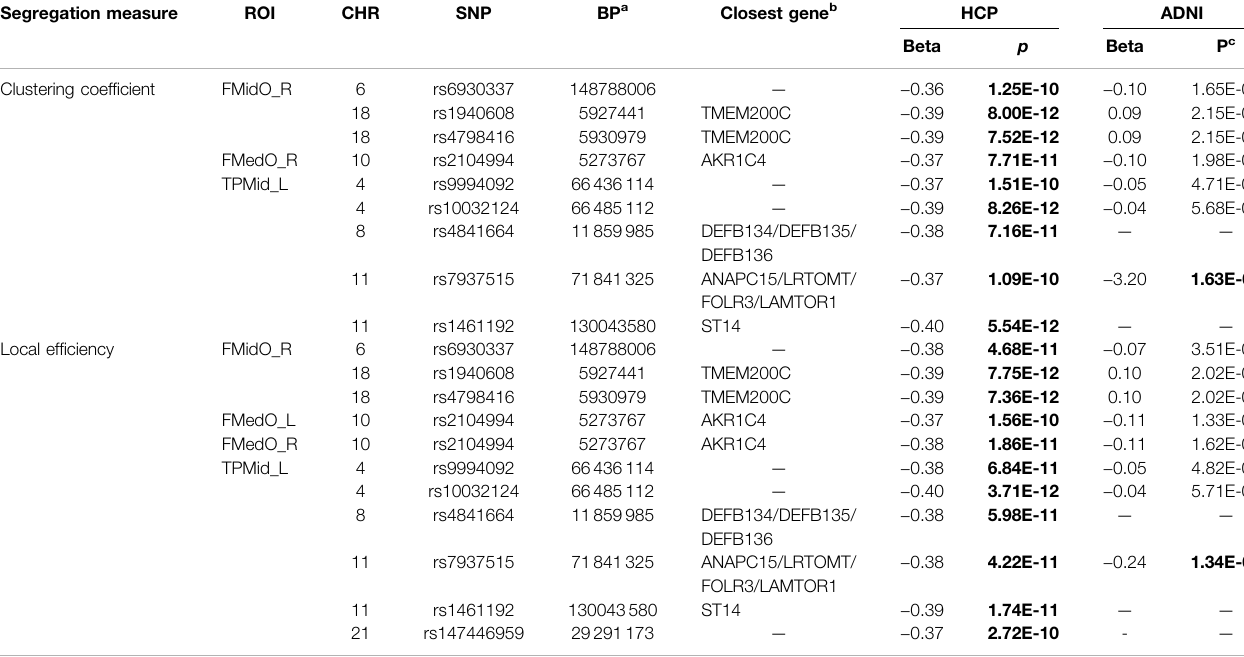
TABLE 2 | Signi fi cant associations between SNPs and segregation measures: statistics in the HCP and ADNI cohorts. Segregation measure